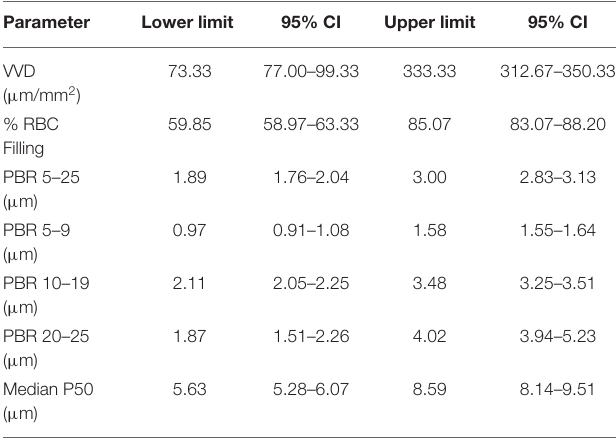
TABLE 3 | Tolerance intervals for GlycoCheck ® parameters in a population of healthy cats ( n = 101). Parameter Lower